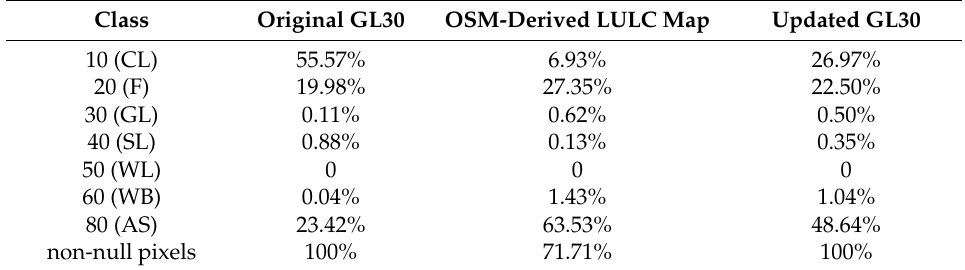
Table 7. Distribution of LULC classes and percentage of non-null pixels in the original GL30, the OSM-derived LULC map and the updated GL30 for Kathmandu study area.